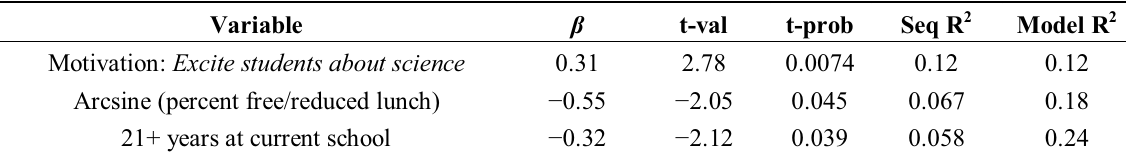
Table 3. Regression of 66 Educate to Eradicate partner (cid:87)(cid:72)(cid:68)(cid:70)(cid:75)(cid:72)(cid:85)(cid:86)(cid:182)(cid:3)(cid:70)(cid:88)(cid:85)(cid:85)(cid:76)(cid:70)(cid:88)(cid:79)(cid:88)(cid:80)(cid:3) continuation on teacher characteristics (surveys A and